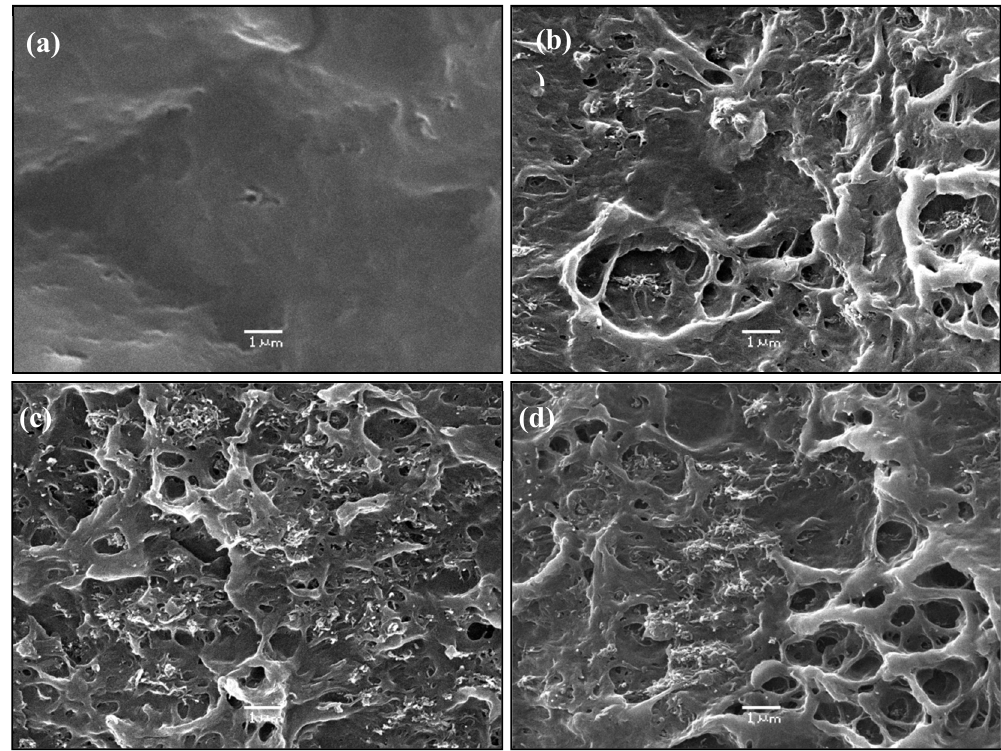
Figure 5. Fracture-surface SEM images of PHBV/MWCNT nanocomposites: ( a ) 0.00 wt %; ( b ) 0.50 wt %; ( c ) 1.00 wt %; ( d ) 2.00 wt % of MWCNTs.